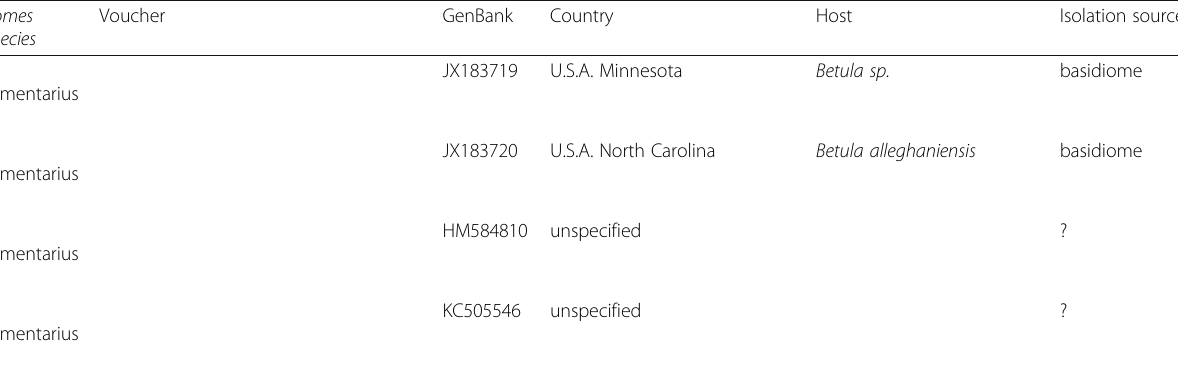
Table 1 Fomes sequences included in the phylogenetic analysis with information on the species identification, the newly sequenced voucher, the GenBank Accession number, and available information on geographic provenance as well as on host plant and isolation source. Sorted based on GenBank Accession number within clades